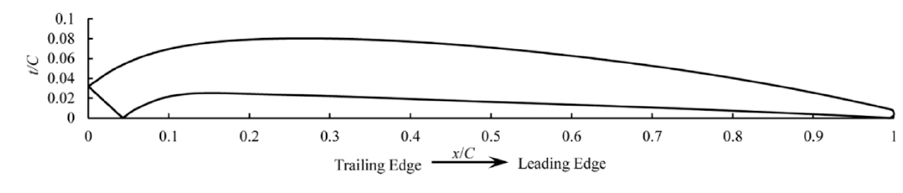
Figure 16. Blade section.